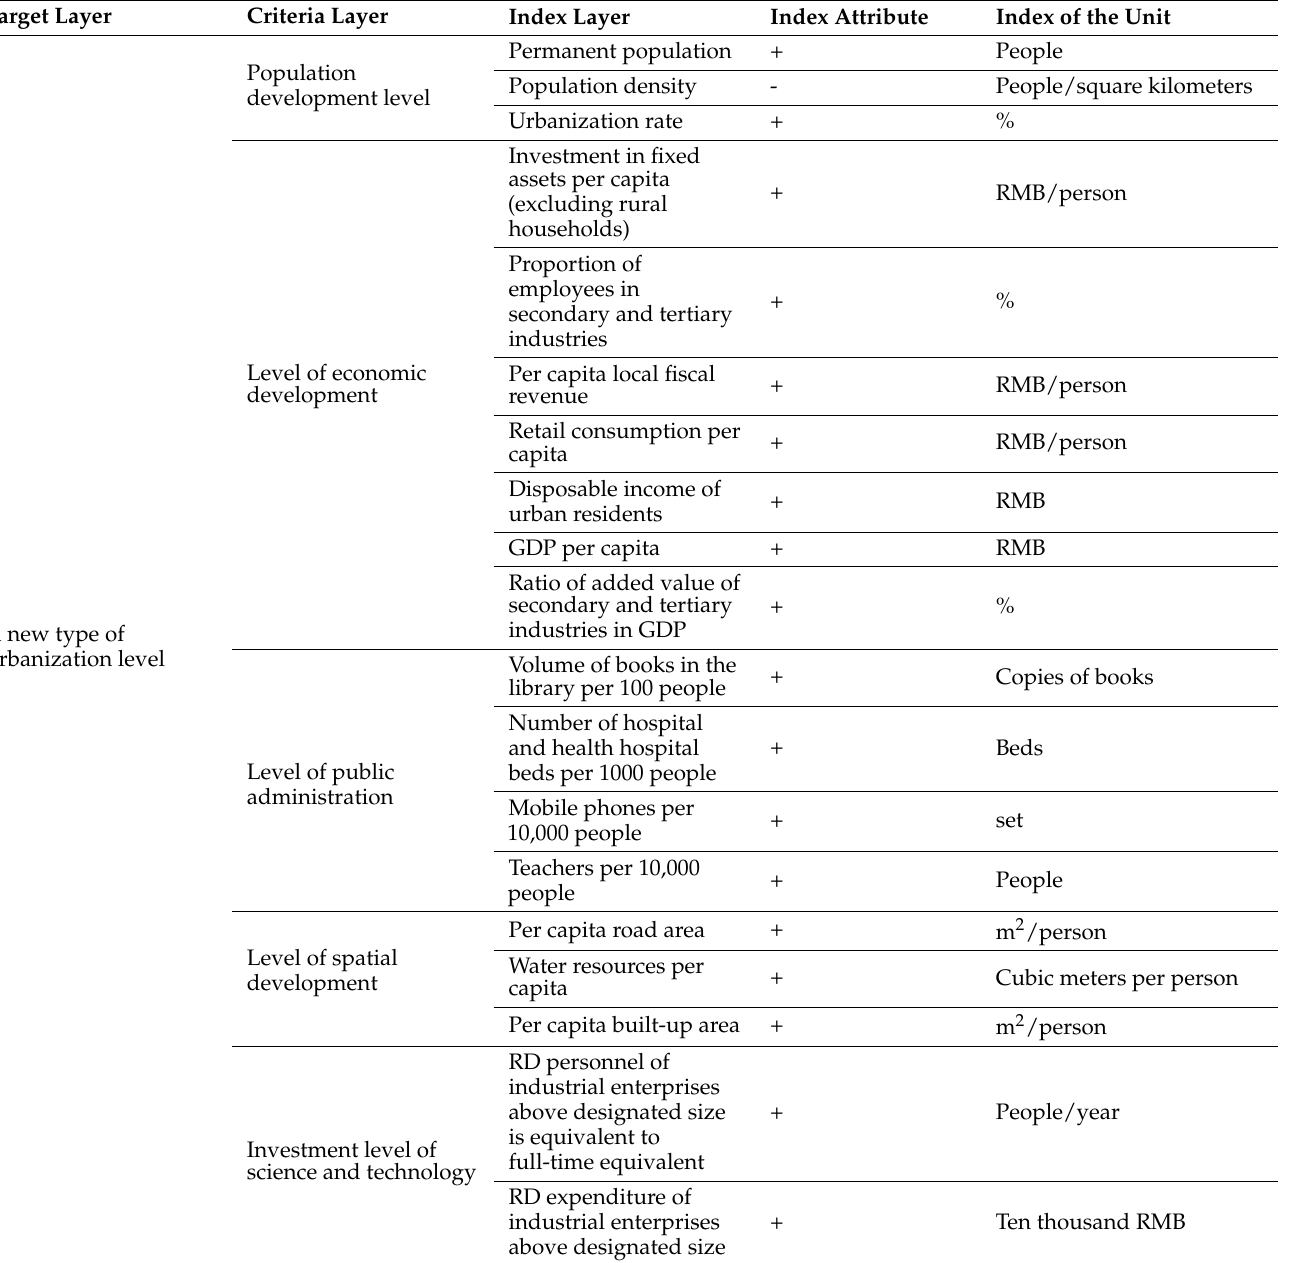
Table 1. Indicator system of new